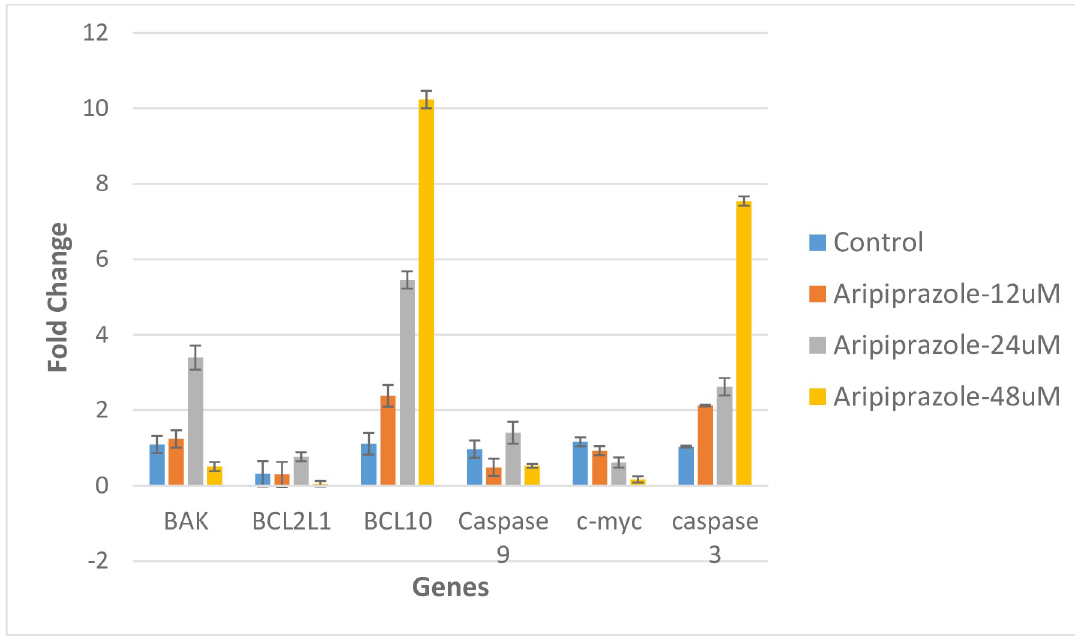
Fig 7. Graphical representation of fold change in mRNA expression. mRNA expression of caspase 3, caspase 9, c-myc, BAK1, BCL 1and BCL-10 calculated by comparative CT method (2 - ΔΔ CT Method) after the treatment of aripiprazole and camptothecin. β -actin and GAPDH were used as a control gene. CT values were obtained, data was normalized against actin and fold change was calculated by Δ CT method. The data are mean ± S.E.M. of three independent experiments, P-values, ( ��� P < 0.001, �� P < 0.001 and � P < 0.05).